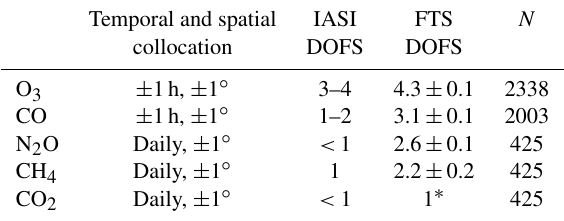
Table 4. Summary of the temporal and spatial collocation crite- ria adopted for each trace gas. Also shown are the typical de- gree of freedom for signal (DOFS) for IASI and FTS products, and the number of coincident observations between IASI and FTS ( N ). For IASI, the expected DOFS for O 3 and CO are taken from the Products User Guide (EUM/OPSEPS/MAN/04/0033, EUMET- SAT), while for CH 4 , N 2 O, and CO 2 those are obtained from Tur- quety et al. (2004) and Clerbaux et al. (2009). The FTS DOFS are calculated from the corresponding retrievals between 2010 and 2014 (median ± 1 σ ). Note that daily means 24h